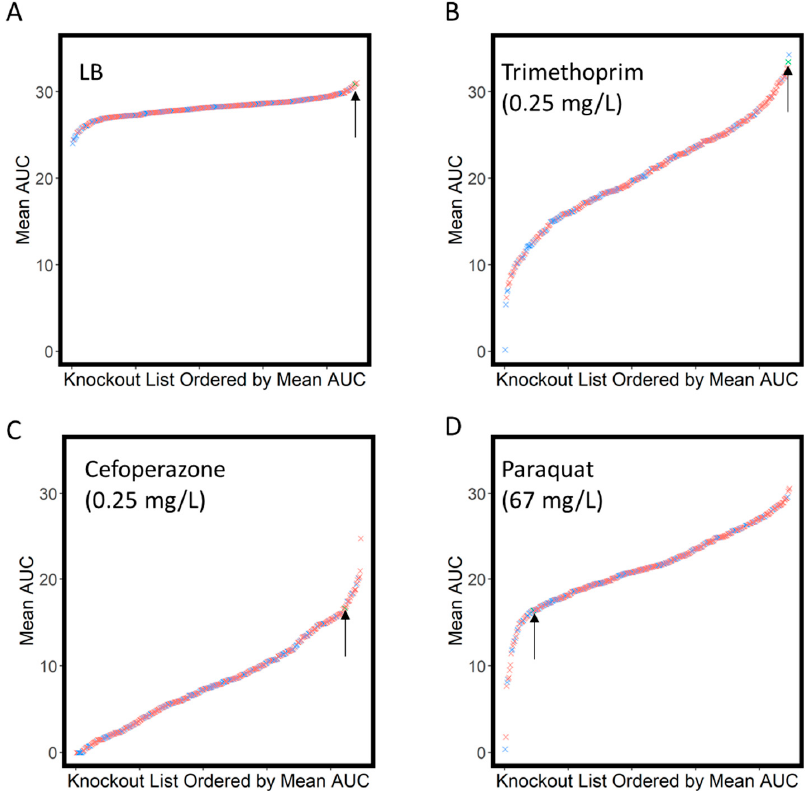
Figure 2. Transporter knockout library ordered by the mean area under the curve (AUC). Data shown for growth in LB ( A ) and subinhibitory concentrations of antibiotics/antimicrobials indicated ( B – D ). Y-genes are shown in blue, and annotated transporters are shown in red, while the arrow indicates the position of the WT strain.